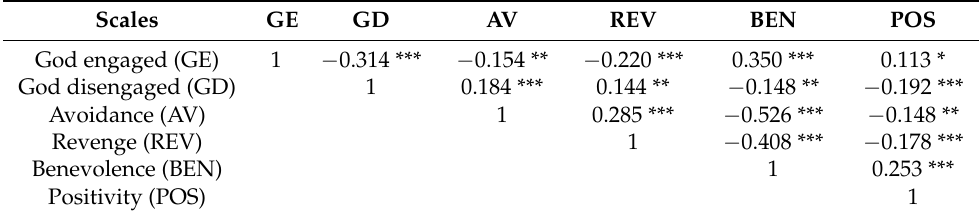
Table 2. Pearson’s correlation results for all measured